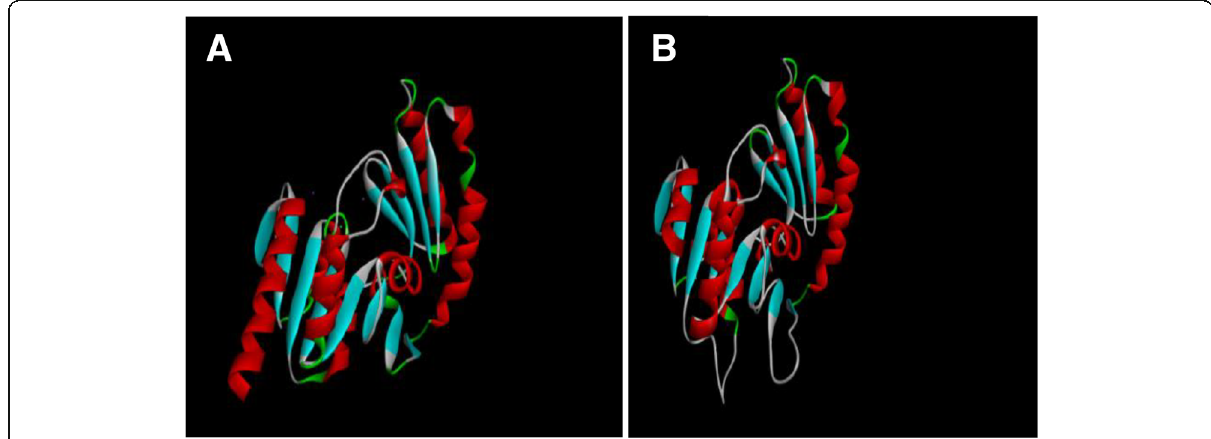
Fig. 3 a 3D structure of TPP (1U02)-related protein from PDB . b Representative Homology model of pathogenic TPP from Swiss